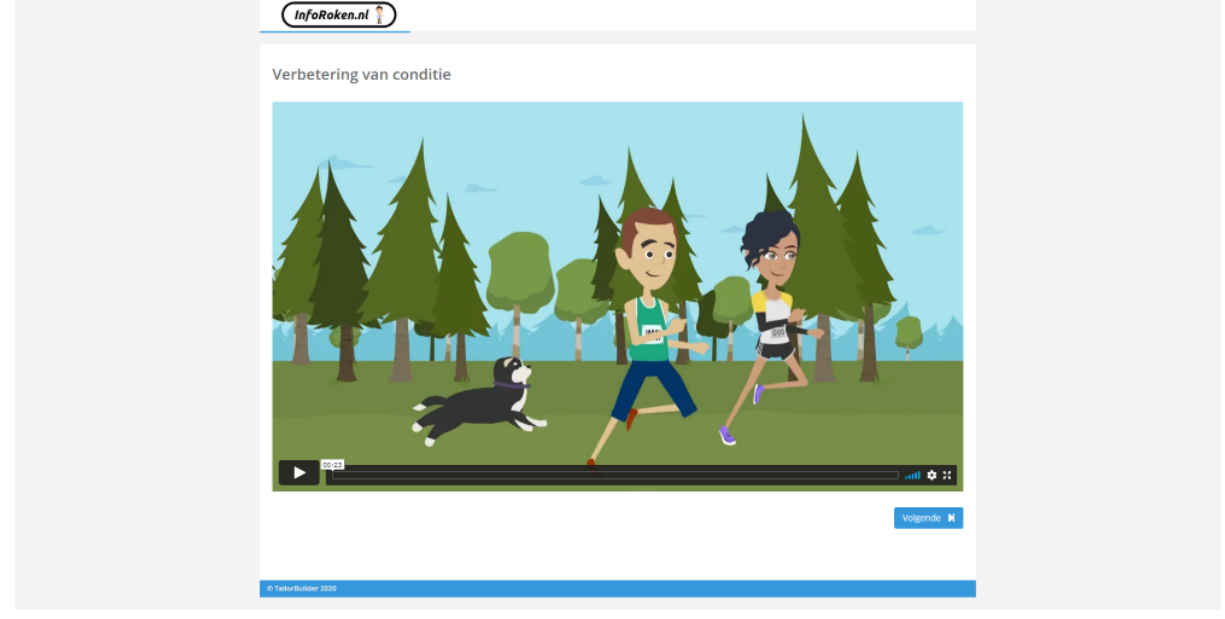
Figure 4. Screenshot of a webpage of the intervention showing an animated video advice.